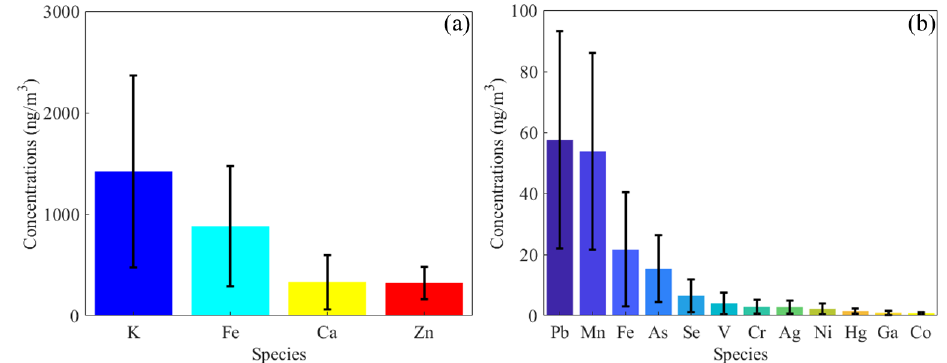
Figure 2. Bar chart of the concentrations of 16 trace elements including K, Fe, Ca, Zn, Pb, Mn, Fe, As, Se, V, Cr, Ag, Ni, Hg, Ga, and Co. The bars and black lines represent mean values and associated standard deviations, respectively.